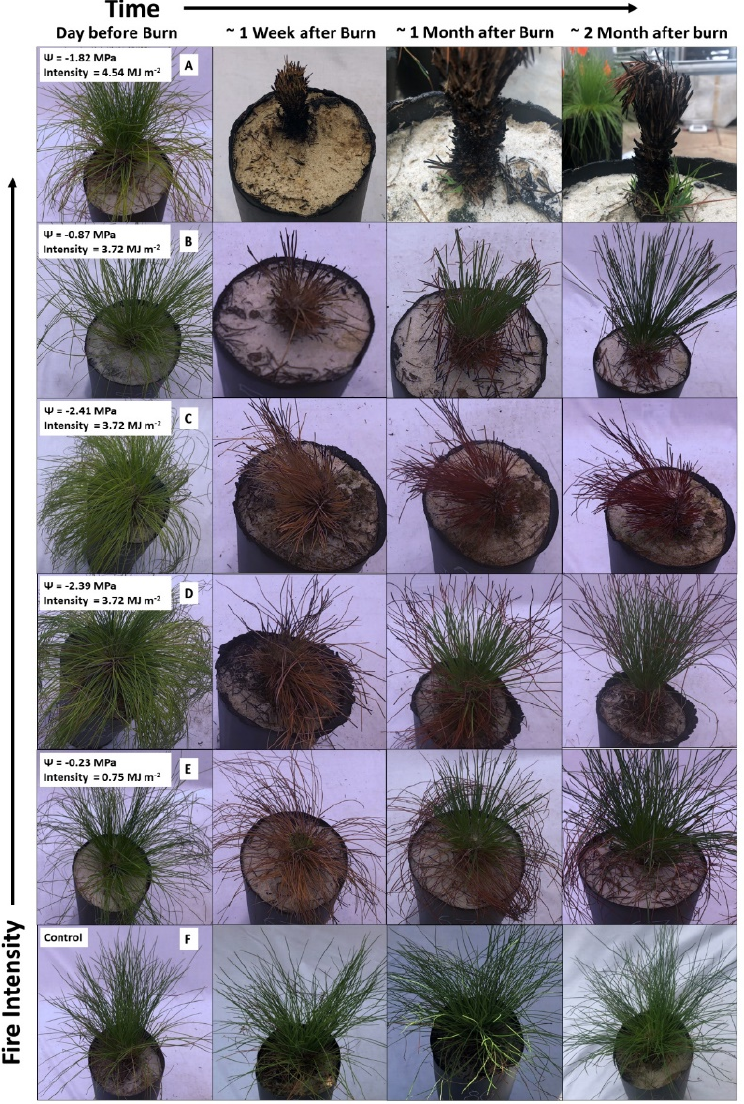
Figure 2. Burned and unburned longleaf seedlings over time. Each column represents a point in time relative to when burned with time since burn increasing to the right. Each row is an individual seedling with the pre-dawn water potential on day of burn ( Ψ ), and individual seedling burn intensity, with intensity between seedlings increasing bottom to top. The first row ( A ) is one of the two seedlings that resprouted. The second row ( B ), is of a seedling with moderate drought but very intense fire, while the third row ( C ) is the only seedling that died. The fourth row ( D ) is of a droughted seedling with moderate to severe intensity burn. The fifth row ( E ) is a seedling that was well watered with a low intensity burn. The sixth row ( F ) is a control seedling with images at the same points in